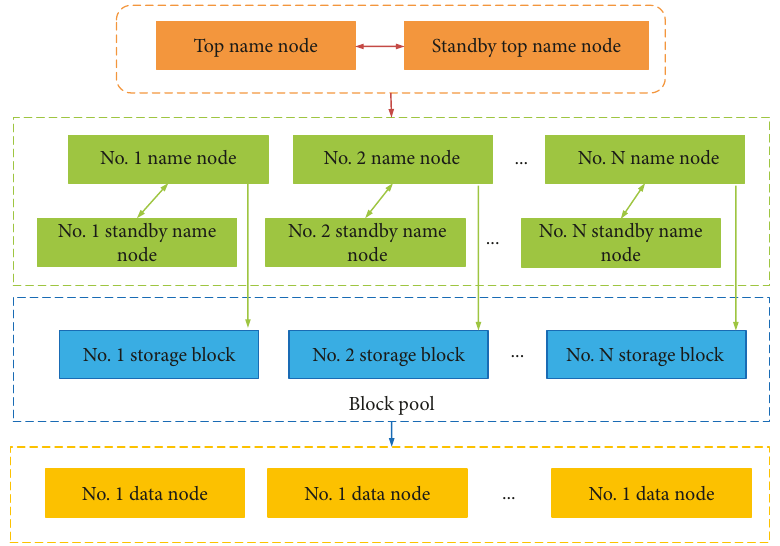
Figure 1: The structure diagram of HDFS system for distributed